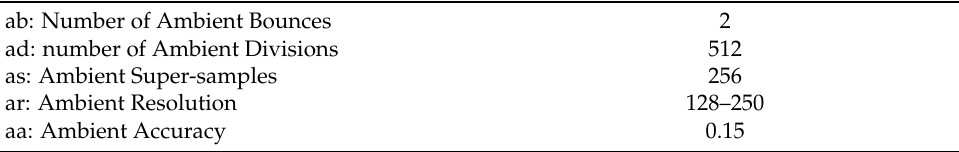
Table 4. Simulation variables in radiance software with good precision.